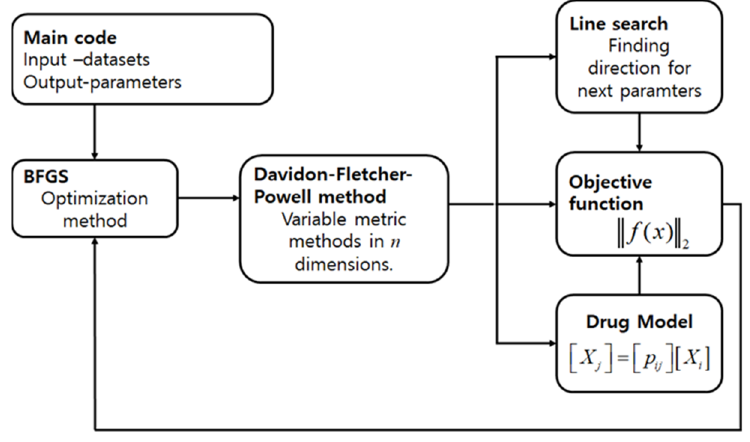
Figure 1. The overall flow chart of the inverse problem.